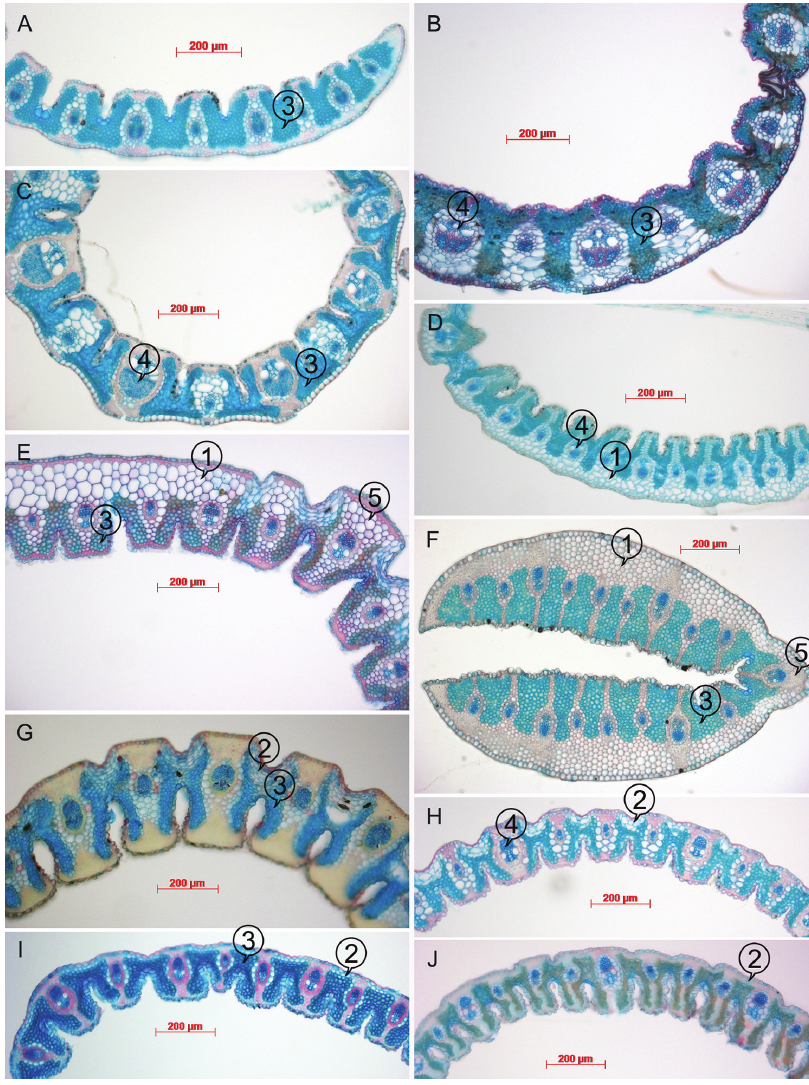
Figure 3. Leaf anatomy of Cortaderia , as evident from transverse sections. A C. egmontiana (Moore 2677) B C. modesta (Glaziou 17913) C C. hieronymi (Garcia 563) D C. nitida (Laegaard 53121) E C. boliviensis (Beck 11273); F C. sericantha (Ramsay 967); G C. echinata (Peterson 21587) H C. bifida (Renvoize 4202) I C. hapalotricha (Laegaard 53305) J C. roraimensis (Maguire 60448). Structures referred to in the descrip- tions are labelled as follows: 1, multi-layered abaxial sub-epidermal collenchyma layer; 2, adaxial islands of collenchyma in the abaxial grooves; 3, chlorenchyma; 4, primary vascular bundle; 5, midrib.